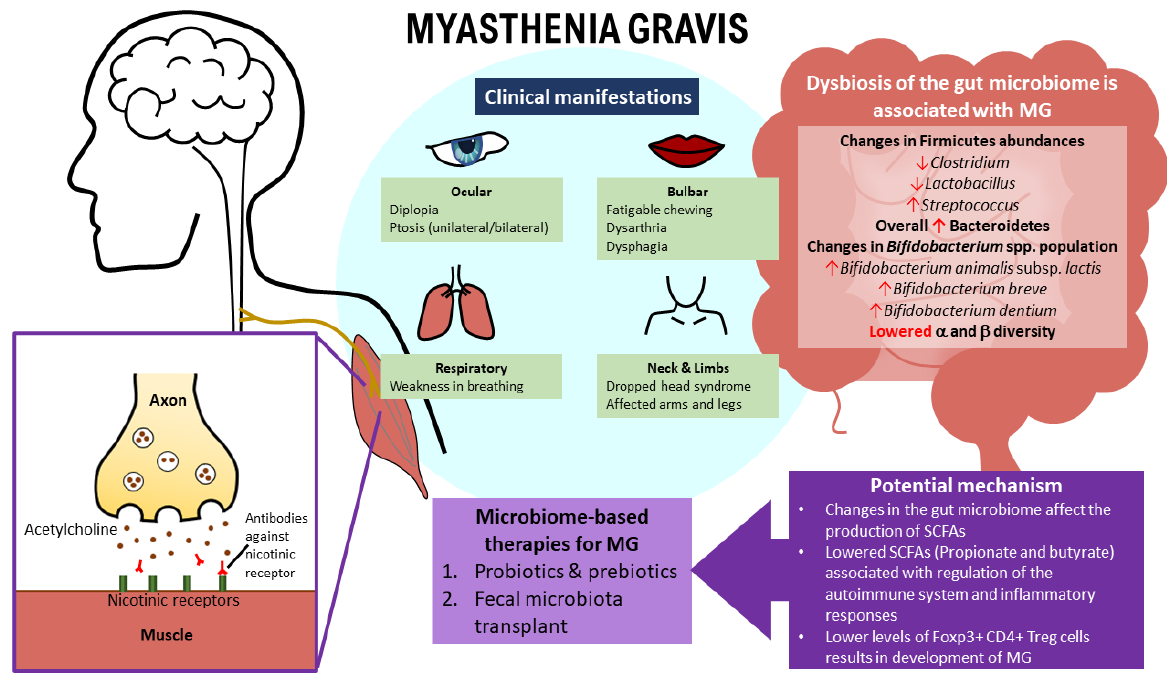
Figure 2. Illustration of how the gut microbiome is associated with the manifestation of myasthenia gravis (MG). It is known that dysbiosis of the gut microbiome could lead to MG’s clinical manifestations. Probiotics, prebiotics, and fecal microbiota transplants are potential microbiome therapies that could be explored and could provide significant benefits to MG patients.